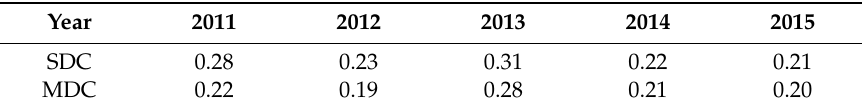
Table 4. Normalized root-mean-square error (NE) values for fractional snow cover area simulations when applying single-dataset and multi-dataset calibration (MDC and SDC) for each year during the validation period.